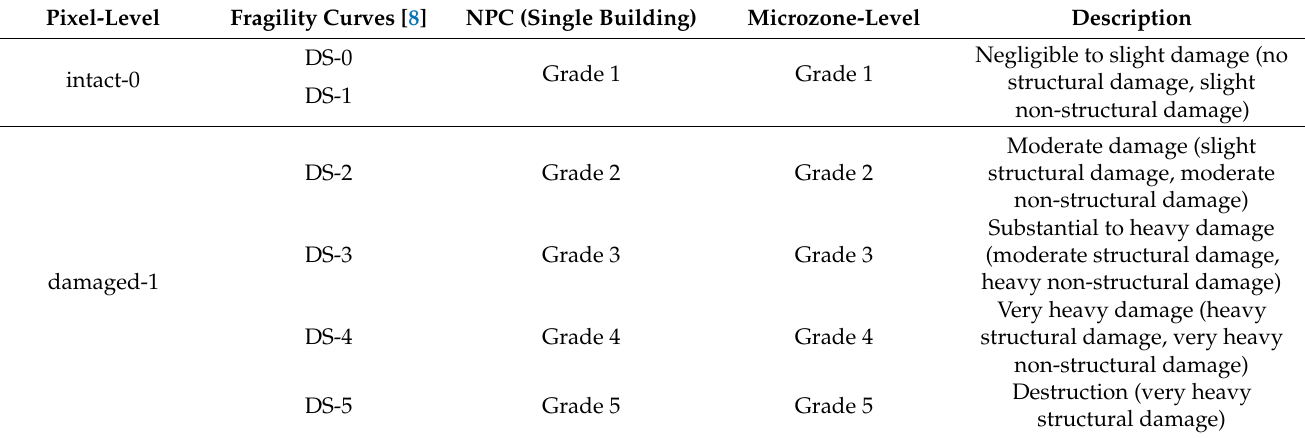
Table 2. Different damage classification systems for Nepal’s